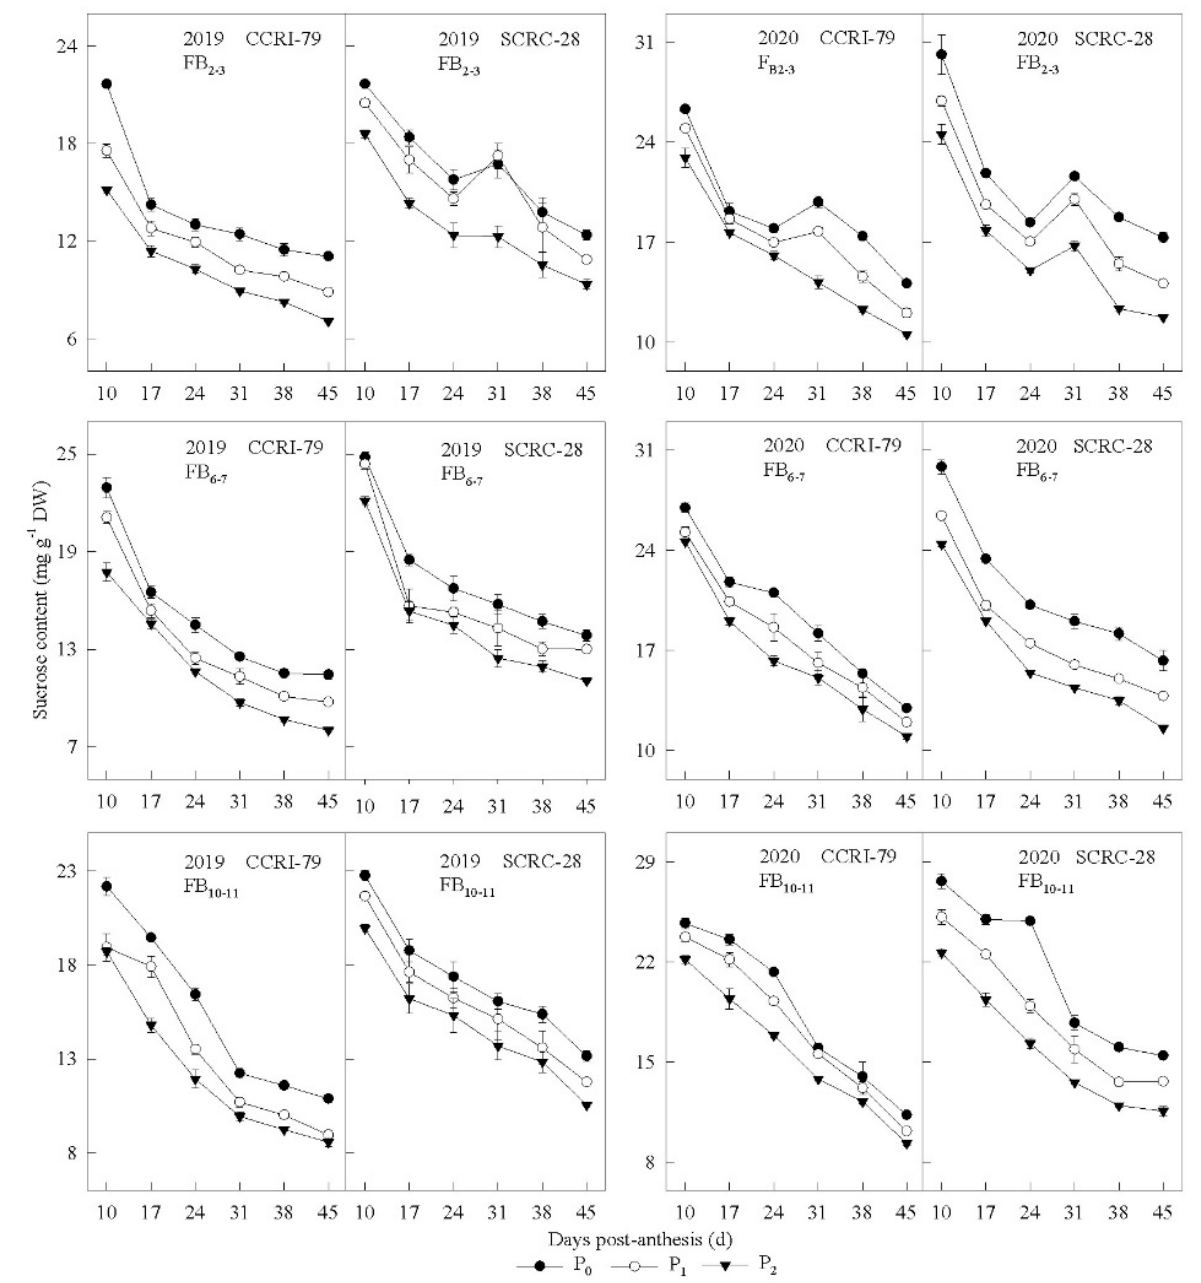
Figure 5. The effect of soil available phosphorus (AP) on the sucrose content of subtending leaves in 2019 and 2020cotton − growing seasons. d: day. FB: fruiting branch. P 0 : 3 ± 0.5 mg kg − 1 . P 1 : 6 ± 0.5 mg kg − 1 . P 2 : 15 ± 0.5 mg kg − 1 .